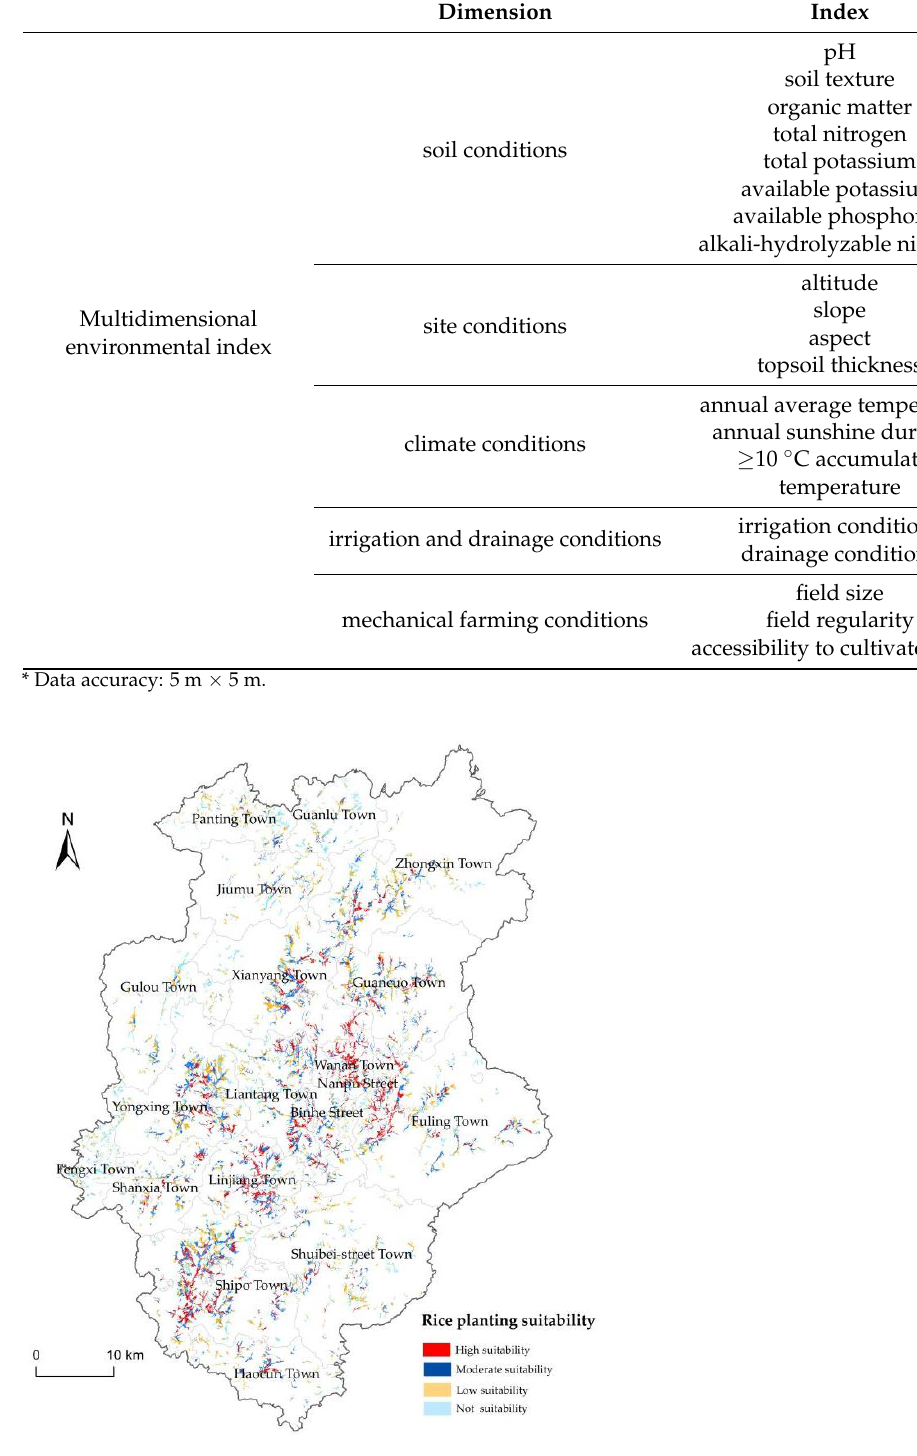
Figure 2. Results of rice planting suitability evaluation in Pucheng County. Table 1. Multidimensional environmental index dataset *.